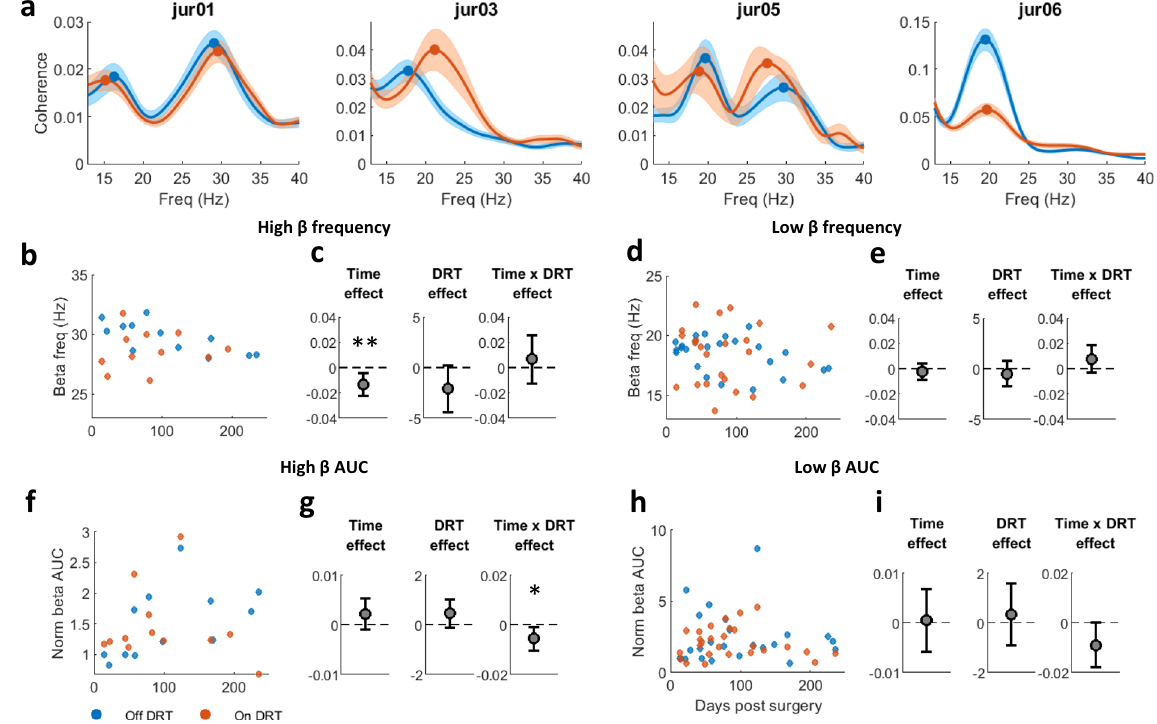
Fig. 8 Dopamine modulation shifts beta-frequency of interhemispheric STN LFP coherence in patients with PD. a Magnitude-squared coherence (mean ± STE) off (blue) and on (red) dopamine-replacement therapy (DRT) in each patient. b , d Frequency of beta-coherence peak in the high ( b )/low ( d ) beta-domains as function of time post-surgery. Each point represents average per day of beta-coherence peak-frequency on (red) and off (blue) DRT. Right: Time, DRT, and interaction effects on beta-coherence peak-frequency estimated by a mixed linear effect model (MLEM), constructed for N = 124 and 205 independent interhemispheric electrode pairs for high-beta frequency ( c ) and low-beta frequency ( e ) models, respectively. Only pairs with signi fi cant beta peak were included in the model. Time ( p = 0.005) had signi fi cant effect on high-beta coherence peak-frequency. Gray circles indicate each factor ’ s coef fi cient in the model, and whiskers indicate con fi dence intervals. Positive and negative coef fi cients indicate positive and negative linear relationship, respectively. In the interaction effect, the coef fi cient presented is of time given on DRT condition. f – i Time and DRT effects on beta synchrony in the high ( f , g )/low ( h , i ) beta-domains. Plot conventions same as b – e . Beta synchrony is evaluated as baseline-corrected area under the curve (AUC) of the coherence in the high ( f , g ) and low ( h , i ) beta-domains. MLEM was constructed for N = 204 and 480 independent interhemispheric electrode pairs for high-beta AUC ( g ) and low-beta AUC ( i ) models, respectively. Time*DRT interaction had signi fi cant effect on high-beta synchrony ( p = 0.0185). Signi fi cance of the fi xed effects was estimated with ANOVA test (Table-S13). Source data are provided as a Source Data fi le. * p < 0.05, ** p < 0.01, *** p <